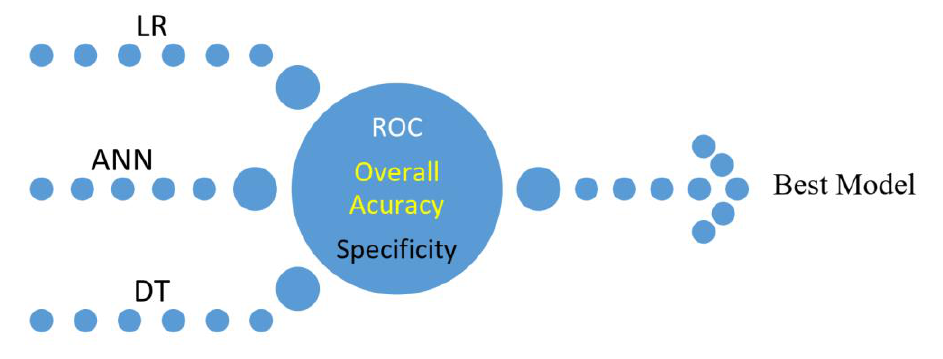
Figure 14. Models